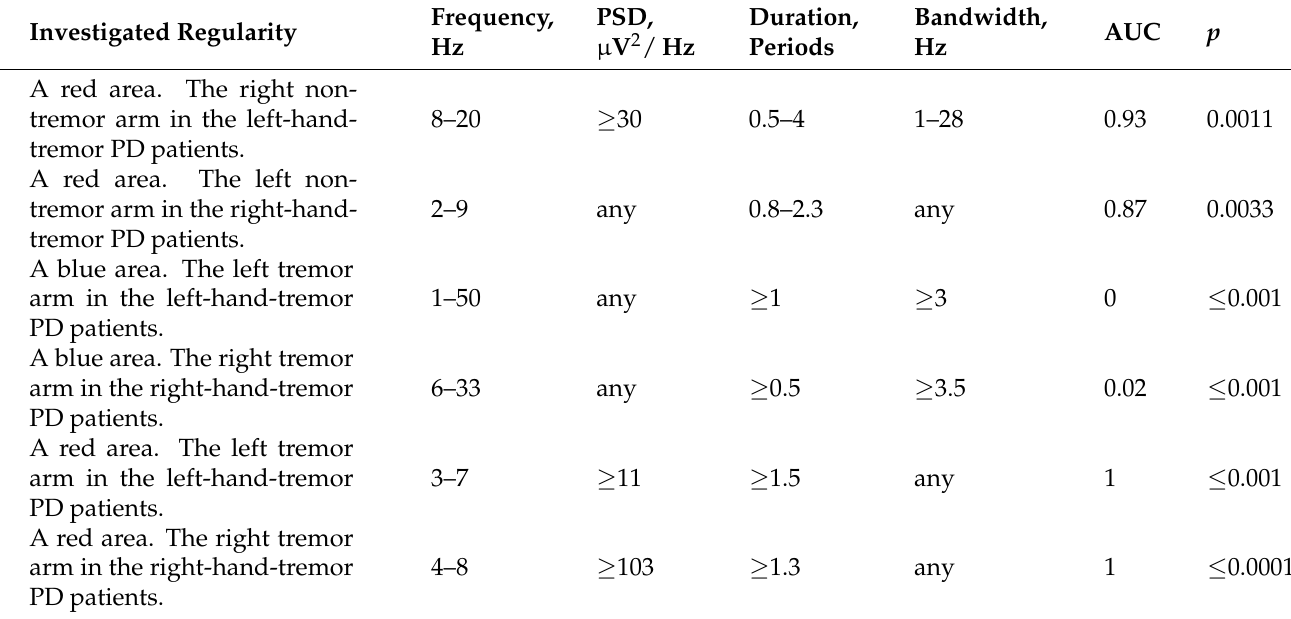
Table 1. The characteristics of the wave trains in the extensor